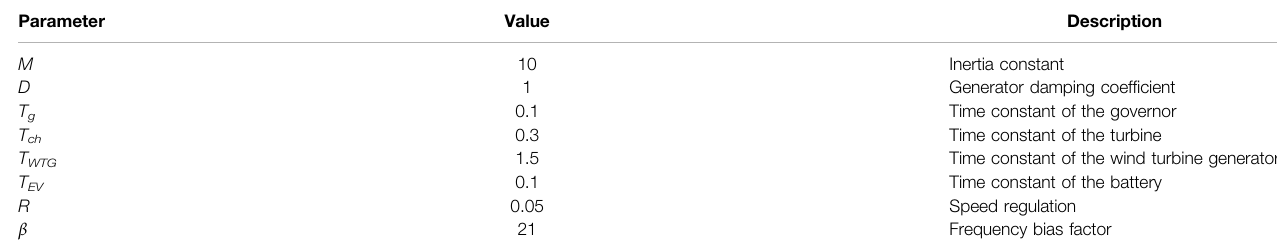
TABLE 1 | Parameter of the LFC